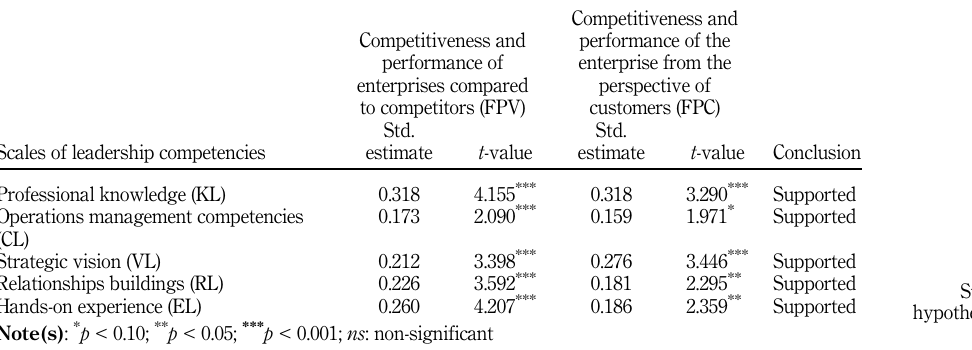
Table 5. Summary